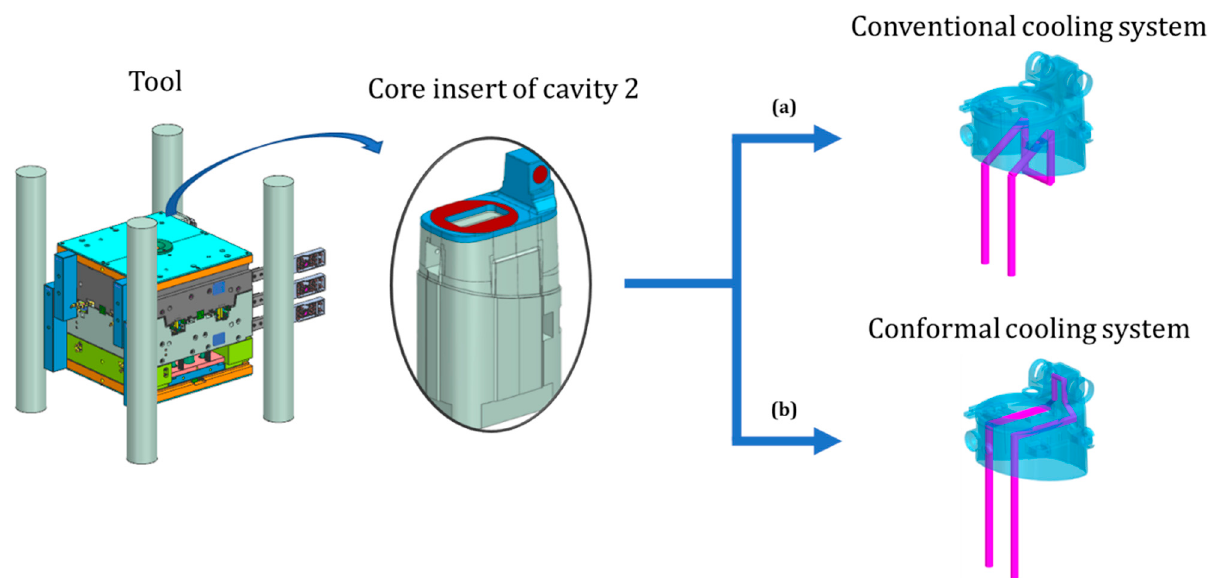
Figure 3. View of the tool showing a detail of the core insert of cavity 2 with a solution for conven- tional ( a ) and conformal cooling ( b ).